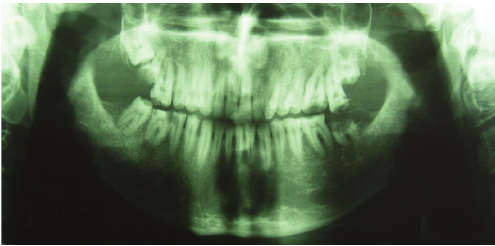
Figure 2: Pretreatment panoramic view.